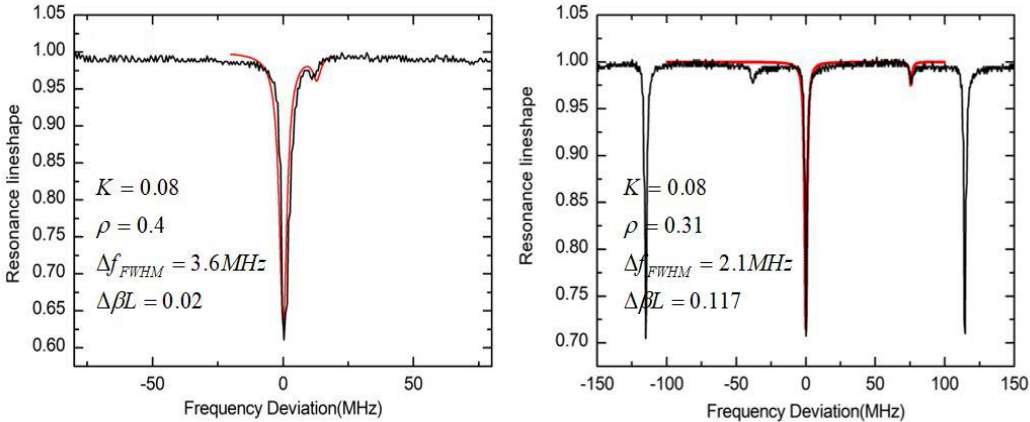
Figure 18. The measured resonance curve and the fitting results of the silicon dioxide WRR.